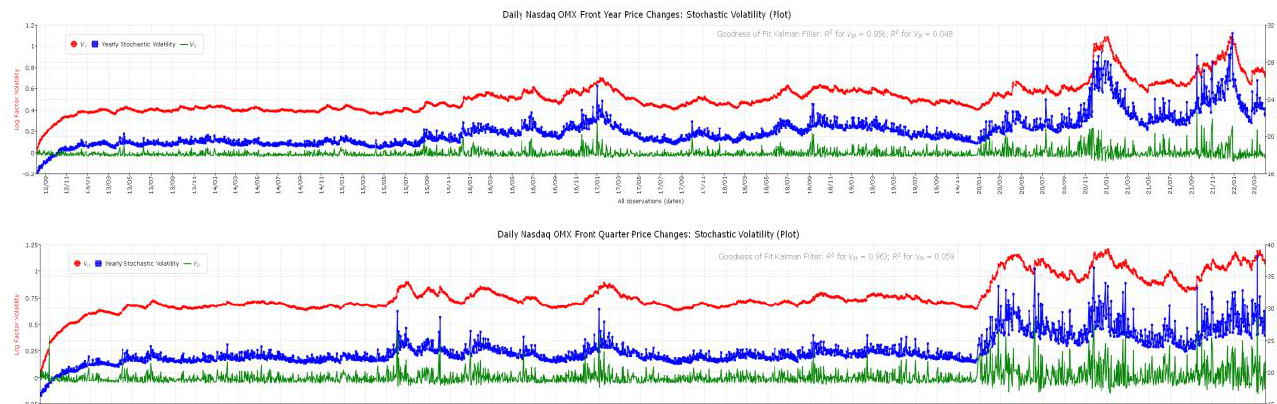
9 of 21 Figure 2. MCMC Posterior Chain from 250 k Optimal SV Model (R = 75.000). 3.3. Nasdaq OMX Front Year and Front Quarter Stochastic Volatility From the two recalibrated SNP models and their associated non-linear Kalman filter, the reprojected volatility for the observed dates is available ( ) , 1 , 2 it V i = . The latent vol- atility is now no longer latent but observable and available for both analysis and forecast- ing. Figure 3 reports factor 1 ( V 1 ), factor 2 ( V 2 ) (left axis), and the ( ) 1 2 ) 252 V V e + (right axis) from the observed data points for the front year (top) and front quarter (bottom) contracts. Interestingly, V 1 is a slow-moving, persistent volatility factor, while V 2 is a fast-moving and strongly mean-reverting volatility factor. The volatility factors in Figure 3 seem to model two different flows of information to the electricity market and the market partici- pants. Market transparency and the flow of information may therefore be classified ac- cording to factors. One slowly mean-reverting factor provides volatility persistence, and one rapidly mean-reverting factor provides for the tails [21]. Furthermore, from the vola- tility paths incorporating the projected yearly volatility () 12 ) 252 VV e + , the volatility seems more influenced by the V 1 persistent factor than the mean-reverting V 2 factor. The line for the V 1 factor is rarely exceeded by the V 2 factor (both measured on the left axis). Figure 3